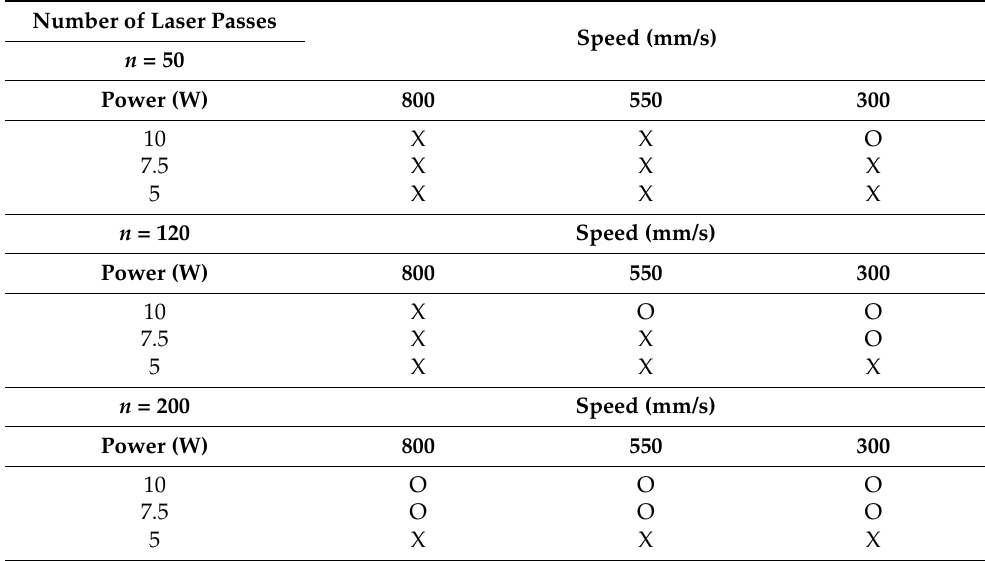
Table 2. Process–ability map indicating the realisation of complete through-cut edges (represented by X) and blind-cutting edges (represented by O) while varying the investigated process parameters. Number of Laser Passes Speed (mm/s) n = 50